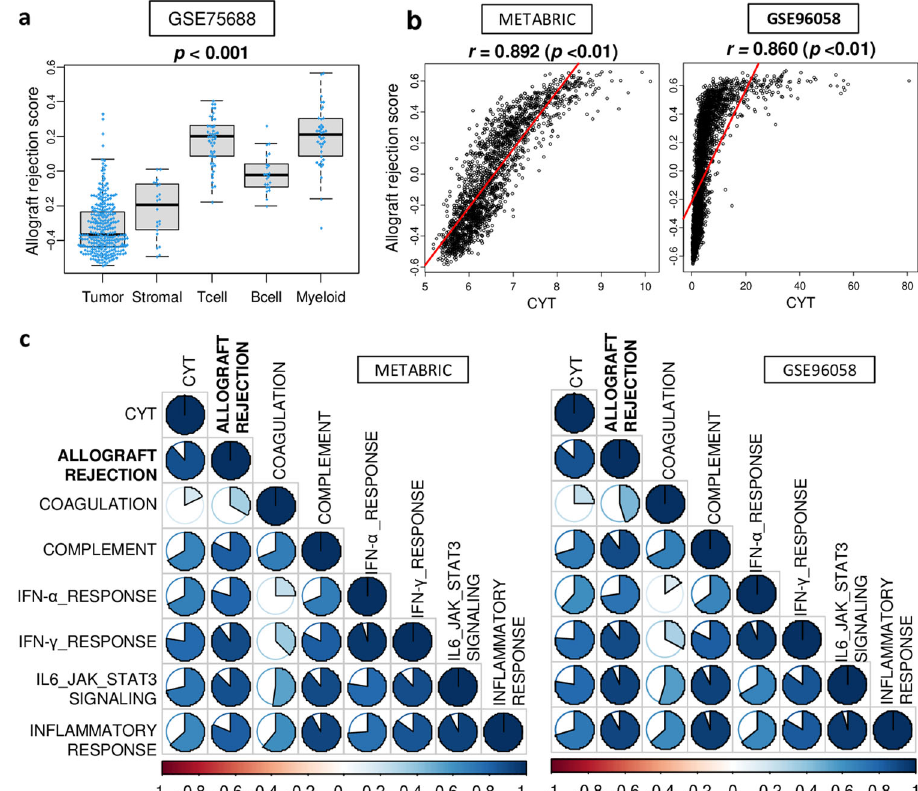
Fig. 1 Allograft rejection score strongly re fl ected anti-cancer immunity in breast cancer. a Boxplots of the allograft rejection score by single cells of the tumor, stromal cells, T cells, B cells, and myeloid cells in the GSE75688 cohort. p -values were calculated by the Kruskal – Wallis test. Boxplots were of Tukey type, with boxes depicting median and inter-quartile range. b Scatter plots between Allograft rejection score and CYT score in both cohorts. Spearman rank correlation was used for the analysis. c Correlation plots between score level of CYT and 8 immune- related gene sets, including allograft rejection, coagulation, complement, interferon (IFN)- α , IFN- γ , IL6/JAK/STAT3/Signaling, and in fl ammatory response in the METABRIC and GSE96058 cohorts. The correlation value is indicated by color (blue for positive correlation and red for negative correlation), while the magnitude of the correlation is shown with